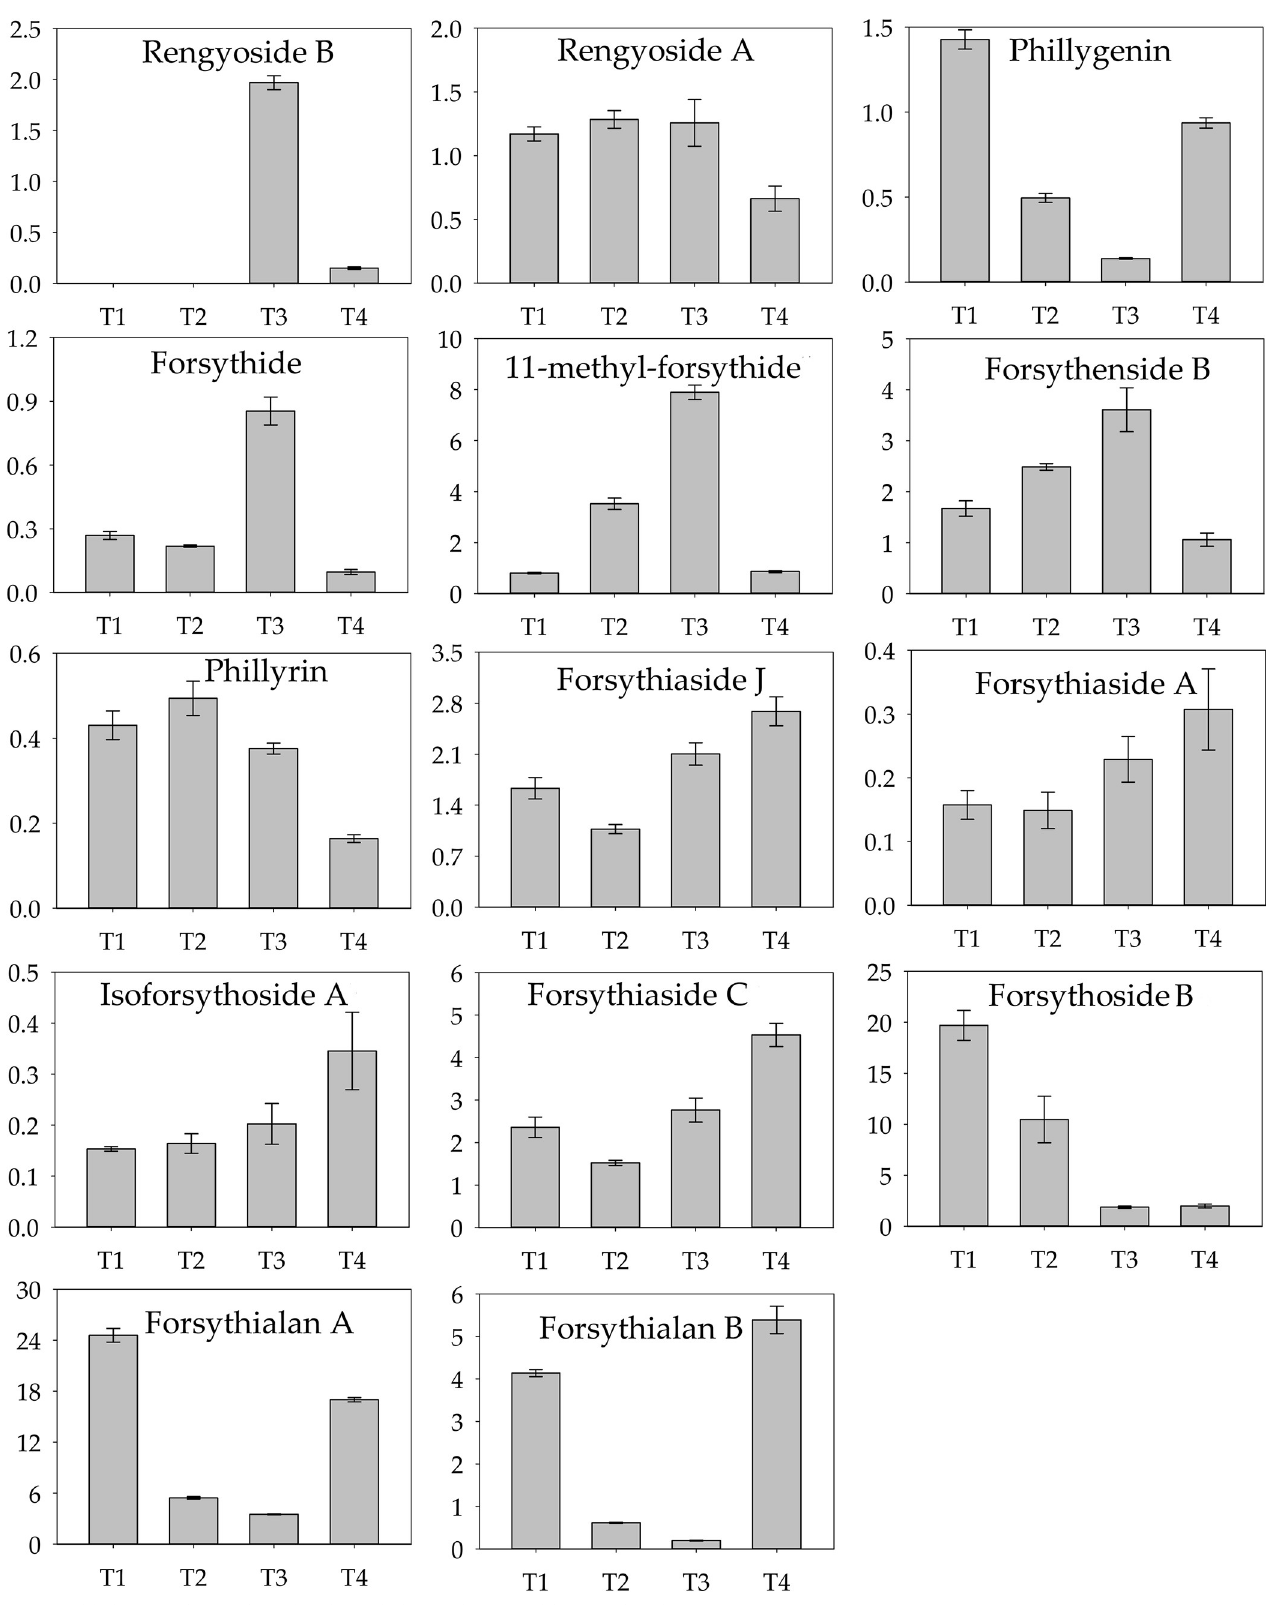
Fig 1. Fold-changes of Forsythia related metabolites in leaves and fruits in four harvesting stages. https://doi.org/10.1371/journal.pone.0269915.g001 PLOS ONE | https://doi.org/10.1371/journal.pone.0269915 June 28,